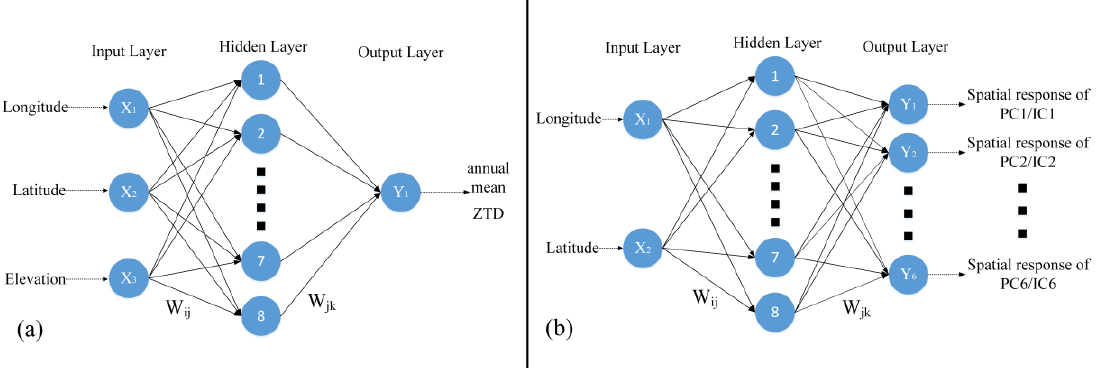
Figure 1. The topological structure of a neural network in this study. ( a ) Annual mean model; ( b ) spatial response model.